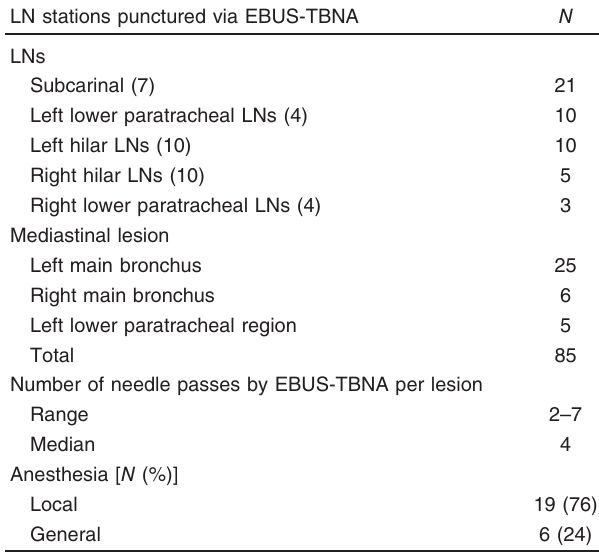
Table 1 General characteristics of the studied cases